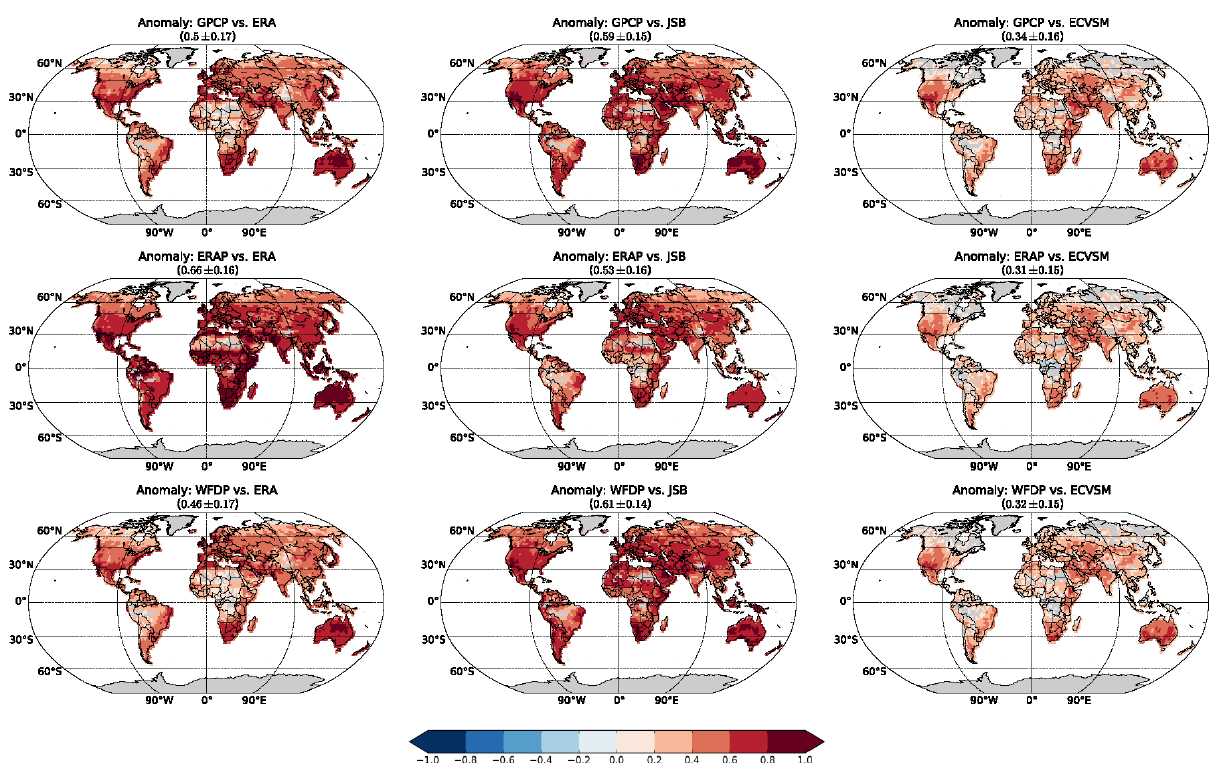
Fig. 6. Significant correlations ( p value < 0.1) of monthly GPCP (top panels), ERA-interim (middle panels) and WFDEI precipitation anoma- lies against ERA-interim (left panels), JSBACH (middle panels) and ECVSM (right panels) soil moisture anomalies.